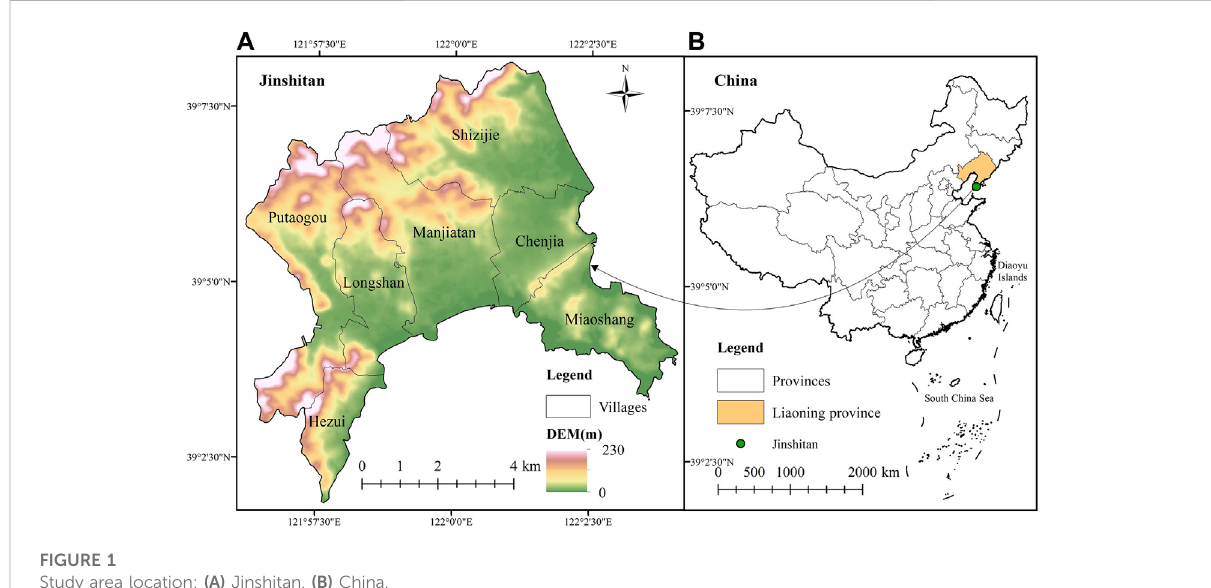
Study area location: (A) Jinshitan, (B)